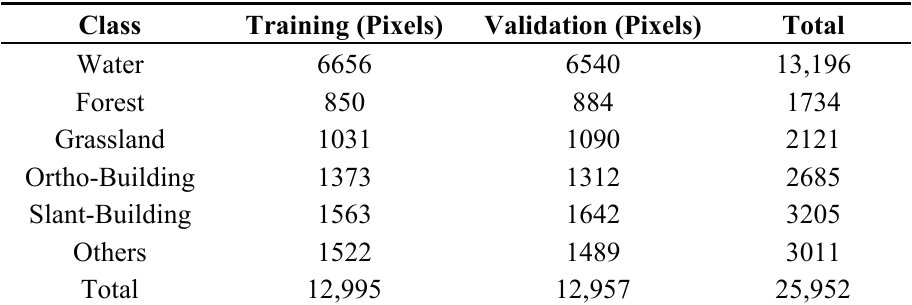
Figure 2. The distribution of the samples shown on the span image. Table 1. Statistical chart of the sample